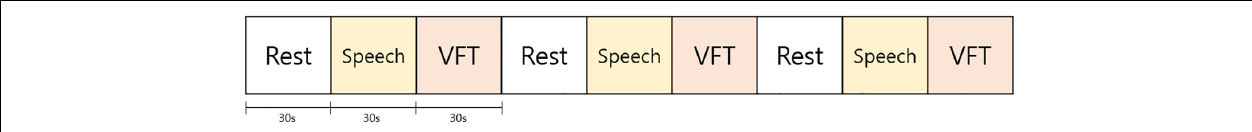
FIGURE 1 | Protocol of verbal fluency test (VFT). At each visit, subjects were exposed to three consecutively repeated trials of rest, speech, and VFT. Each trial lasted 30 s. In each speech trial, subjects were asked to repeat the articulation of “giyeog-nieun-digeud-lieul” for 30 s. In the VFT trial, subjects were asked to produce as many words beginning with a specific consonant as